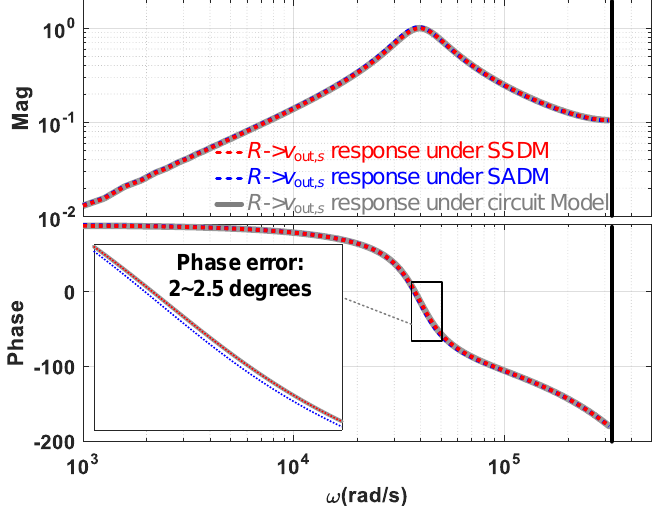
Figure 13. Frequency response from R to v out, s under the SSDM, SADM, and circuit model.